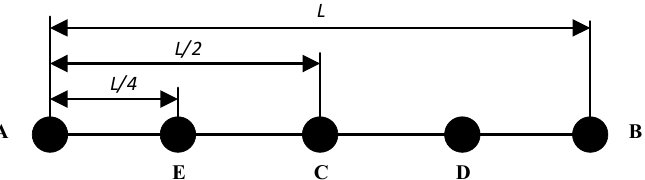
Figure 4. Schematic diagram of dividing the line AB into n equal parts. C and D, E are the points where the line segment AB is halved and quartered, respectively.